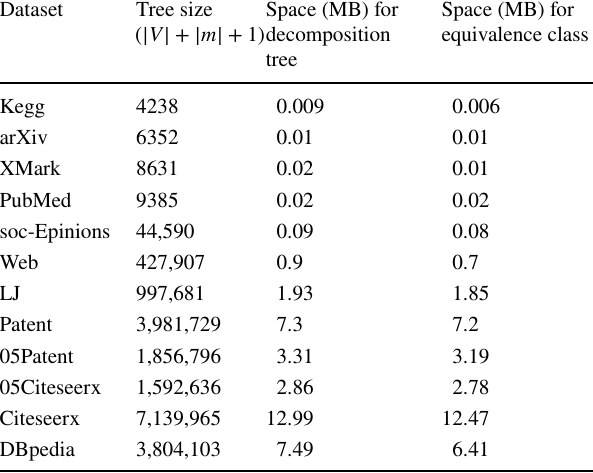
Table 3 Size and storage space for decomposition tree